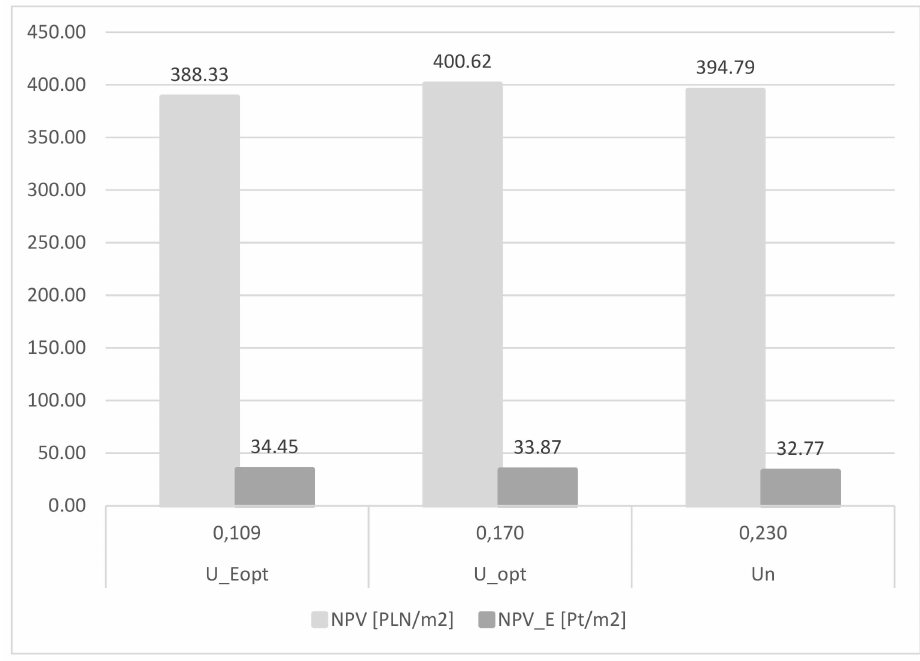
Figure 3. NPV and NPV E values depending on U for variant LSB-CGB-MW and climate zone III.